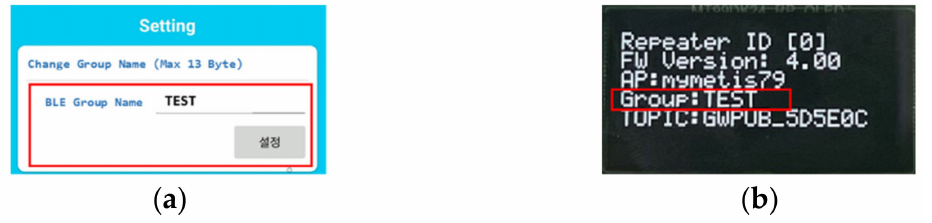
Figure 14. Setting and modification of central processor group information through the app: ( a ) setting and modification; ( b ) verification of group name and BLE ID.